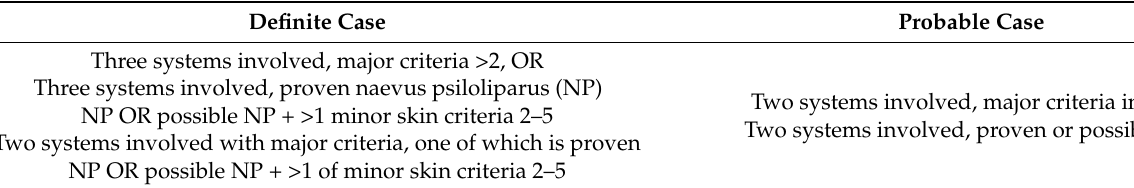
Table 2. ECCL application criteria for diagnosis